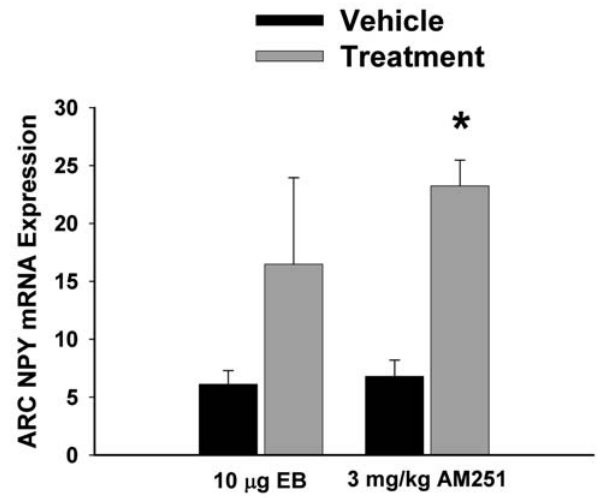
Figure 10. The effects of EB and AM251 on NPY expression in the ARC. Bars represent means and vertical lines 1 SEM of the preproNPY mRNA expression determined in ARC tissue harvested after the feeding experiments. *, Values measured in EB- and AM251-treated animals that are significantly different (Student’s t-test; p < 0.05; n=5 − 8) than those measured in vehicle-treated